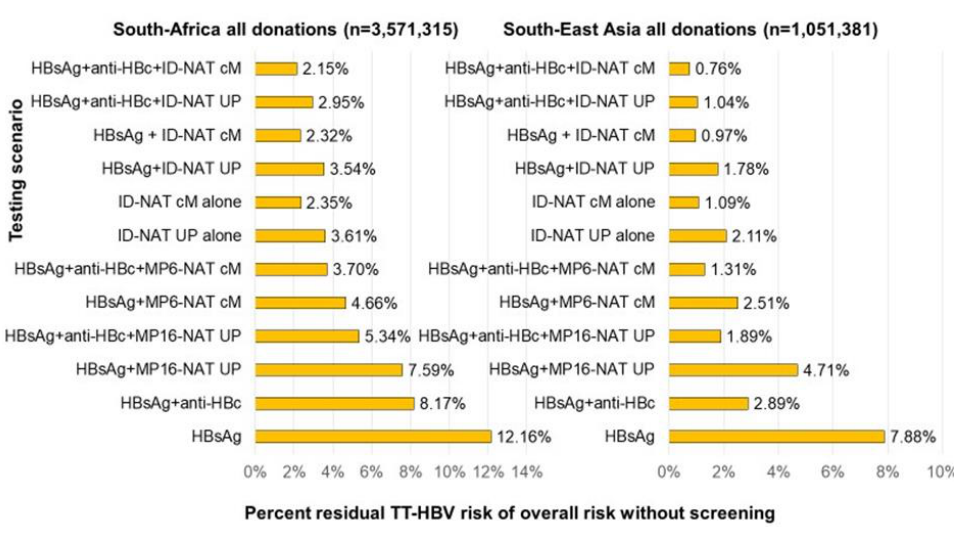
Figure 5. Residual TT-HBV risk for RBC transfusions based on screening data in two of the four geographical regions estimated for 12 testing scenarios (UP = Ultrio Plus, cM = cobas MPX, MP6 = minipools of 6; MP16 = minipools of 16) and expressed as a percentage of the overall risk in case no HBV testing had been performed.